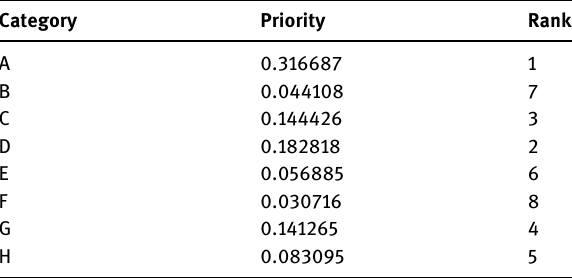
Table 4: AHP priority weightage for selected parameters Category